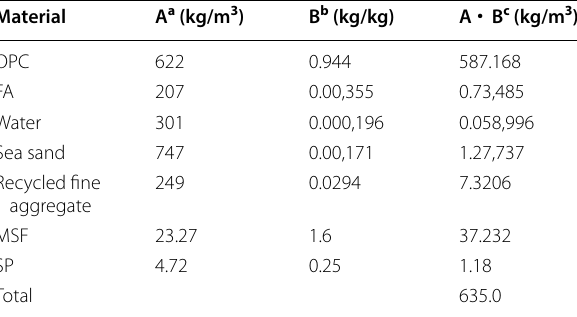
Table 6 Example of CO (W/B =